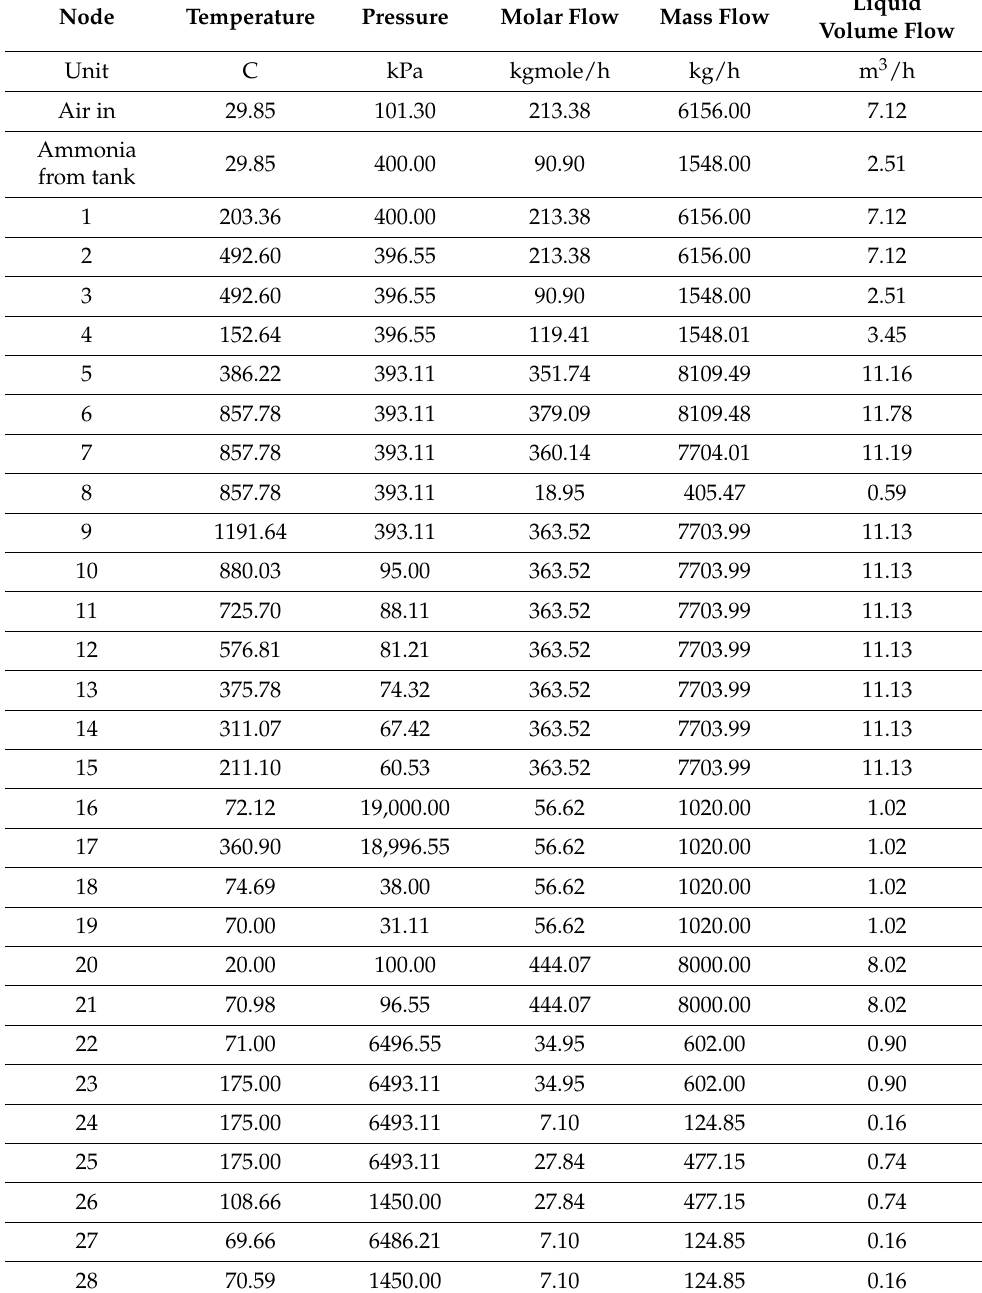
Table 9. Operational specification of each node of proposed